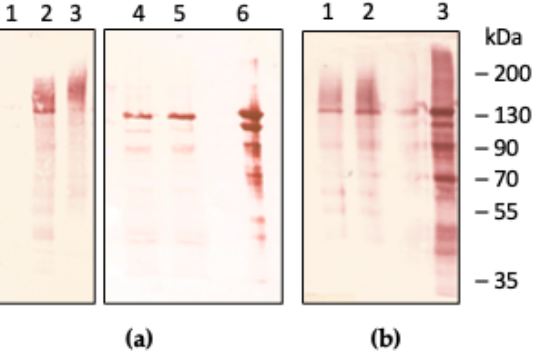
Figure 1. Western blot analysis of expression of recombinant human CP in P. pastoris . Panel ( a ): untransformed SM5 fet3 ∆ (lane 1), CP expressed in fet3 ∆ strains derived from SM5 (lane 2) or JC300 (lane 3); samples after treatment with EndoH are shown in lanes 4 (SM5) and 5 (JC300); lane 6, plasma-derived CP (200 ng). Panel ( b ): pOst1-alfaF-CP (lane 1) and CP with its native signal peptide (lane 2) expressed in SM5 fet3 Δ . Lane 3, plasma-derived CP (200 ng). Yeast cells were grown to OD 600 = 2 and culture supernatants were collected and concentrated 30-fold; 20 μ L of concentrated culture supernatants was loaded on the gel.